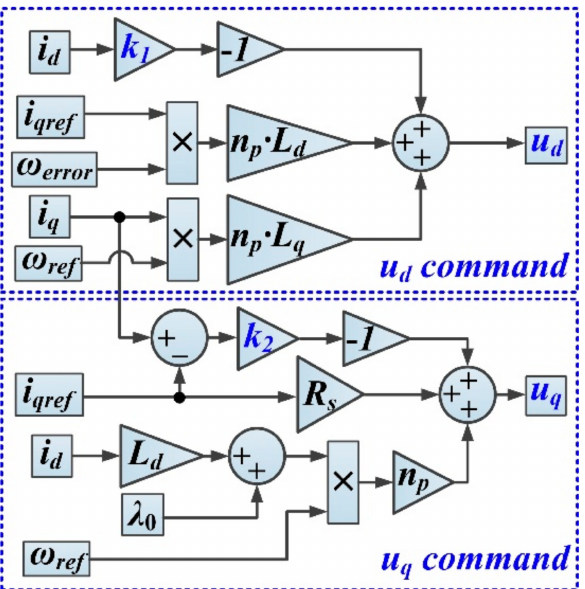
Figure 8. Schematic representation of a PCH controller: u d and u q